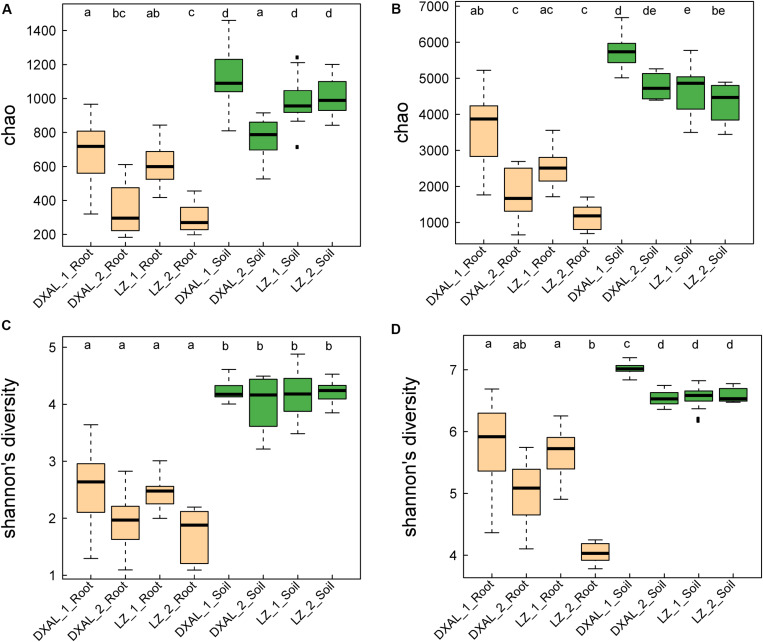
Species richness and diversity of root-associated microbial communities. (A) Microbial richness index comparison between each group based on the Chao index using the ITS data. (B) Microbial diversity index comparison between each group based on the Shannon index using the ITS data. (C) Microbial richness index comparison between each group based on the Chao index using the 16S rRNA gene data. (D) Microbial diversity index comparison between each group based on the Shannon index using the 16S rRNA gene data. Significant differences are depicted with letters (P < 0.05, Kruskal–Wallis with Dunn’s post hoc test). DXAL: Greater Khingan Mountains, LZ: Linzhi, 1: vegetative growth stage, 2: reproductive growth stage.